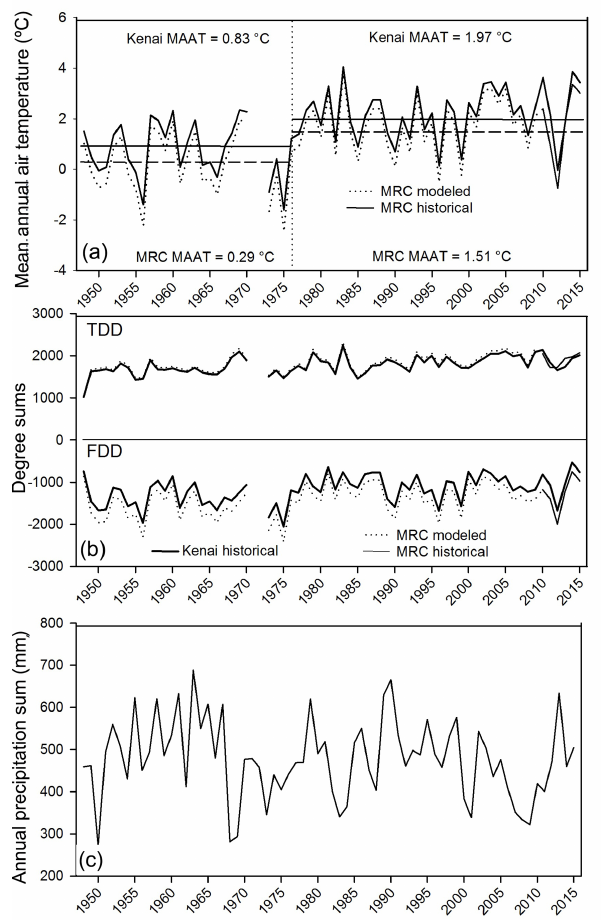
Figure 2. (a) Historical (1948–2015) mean annual air temper- ature compiled from Kenai Municipal Airport (WBAN 26523) hourly surface data and interpolated (broken) and measured (solid) mean annual air temperature for the MRC station (Kenai 29 ENE AWS 702590). (b) Thawing degree day (TDD) and freezing de- gree day (FDD) sums for 1948–2015 derived from historical and interpolated daily mean temperature. (c) Cumulative annual precip- itation data from the Kenai Municipal Airport (WBAN 26523) be- tween 1948 and